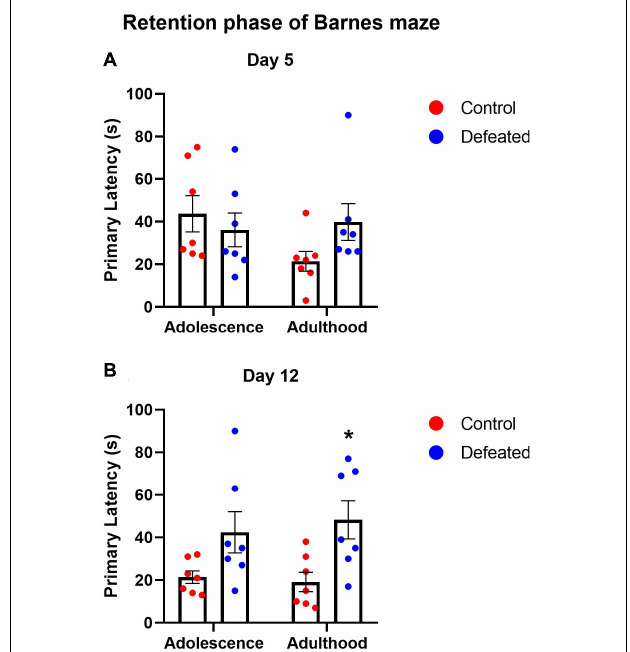
FIGURE 3 | Effects of the CSD in the Barnes maze on the primary latency after 5 days (A) and 12 days (B) of the retention phase in both adolescence and adulthood. Data are presented as the mean ± SEM of the primary latency. Two-way ANOVA, post hoc Sidak’s test, * p < 0.05, n = 7.